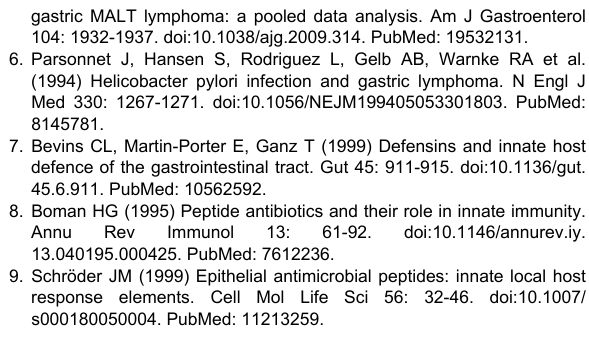
Table S1. Sequences of recombinant peptides used in the antimicrobial